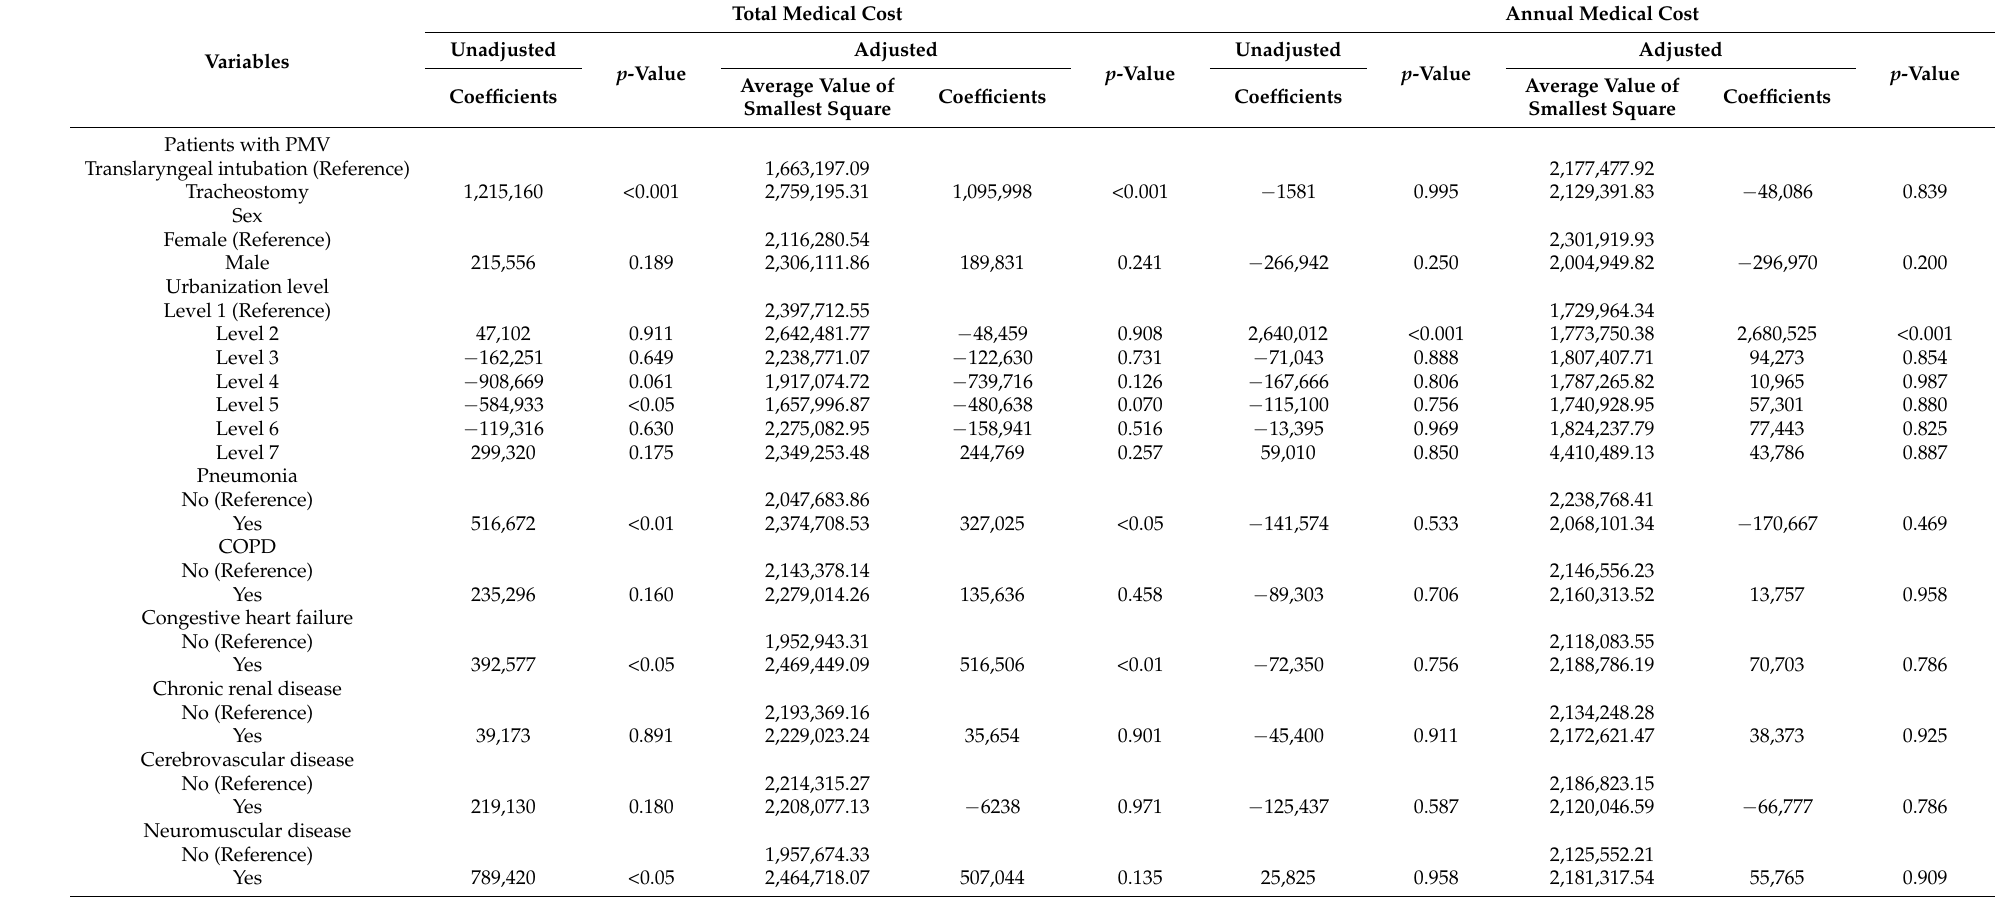
Table 5. Linear regression model of medical costs in patients with